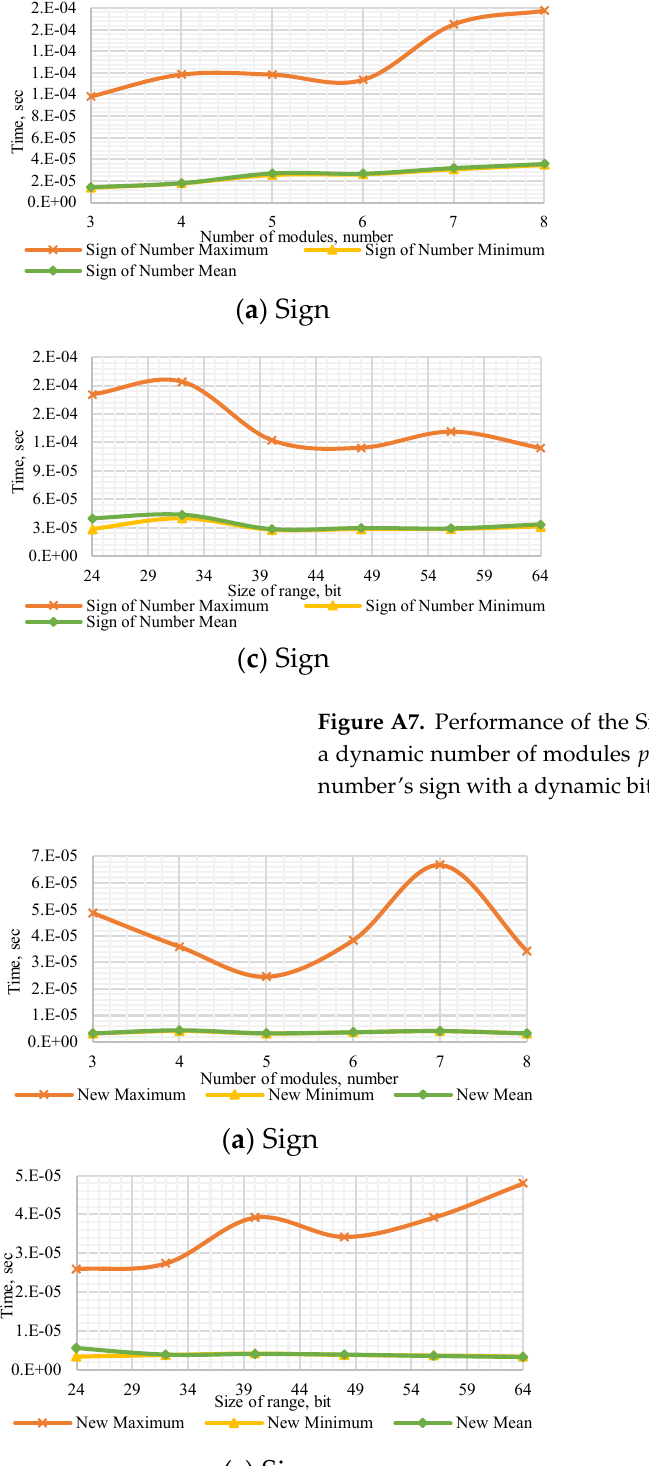
Figure A6. Performance of the Modify Diagonal Method to ( a ) determine the number’s sign with a